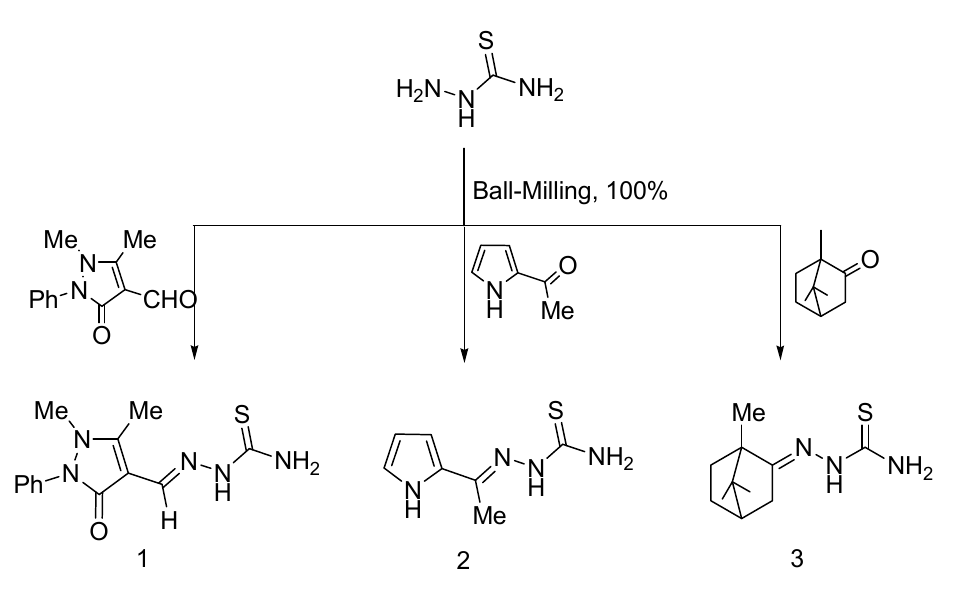
Scheme 1. Synthesis of thiosemicarbazones 1 , 2 and 3 using the ball-milling technique at room